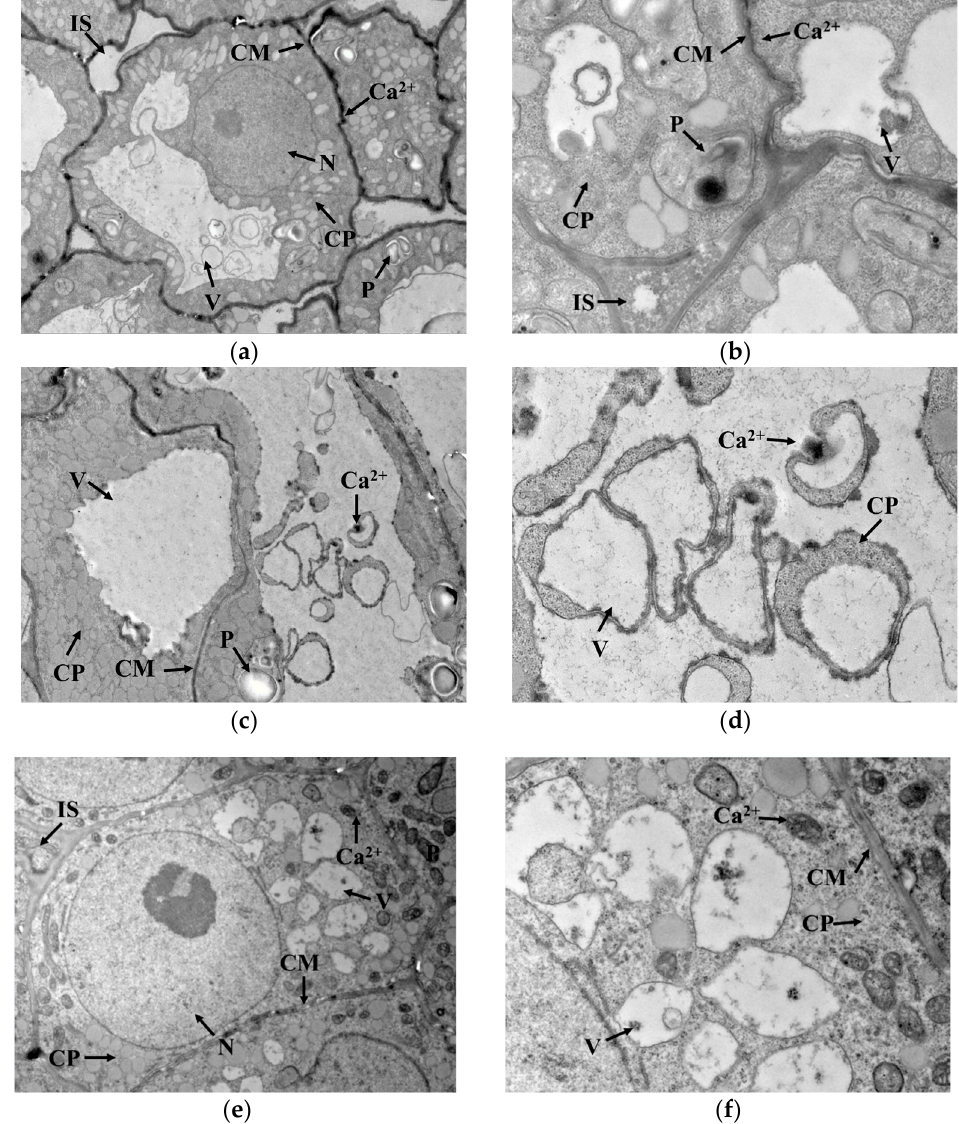
Figure 4. Localization of Ca 2+ in germ cells: ( a , b ) represent the localization of Ca 2+ in germ cells under no cold stress with magni fi cation at 2000× and 6000×, respectively; ( c , d ) represent the localization of Ca 2+ in germ cells under cold stress at 0 °C for 1 h with magni fi cation at 2000× and 6000×, respectively; ( e , f ) represent the localization of Ca 2+ in germ cells under cold stress at 0 °C for 15 h with magni fi cation at 2000× and 6000×, respectively; N: nucleus; V: vacuole; IS: intercellular space; CP: cytoplasm; P: plastid; CM: cytomembrane. The areas indicated by the arrow with “Ca 2+ ”are the precipitates formed by calcium pyroantimonate.